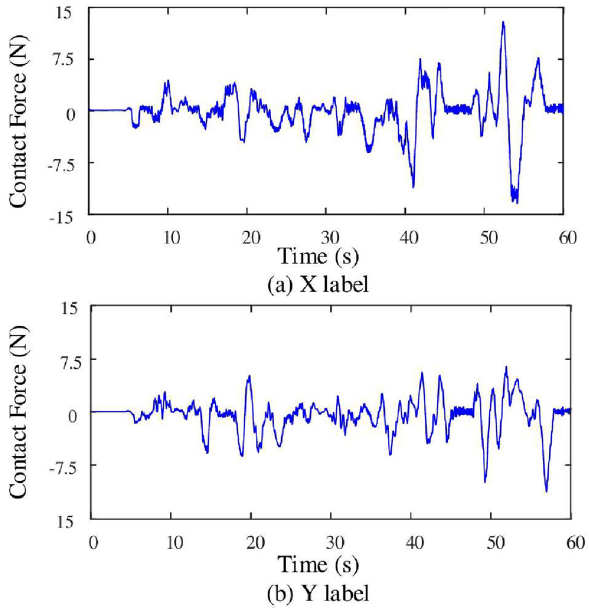
Fig. 16 Human–robot interaction contact force curves under existing decentralized robust control method